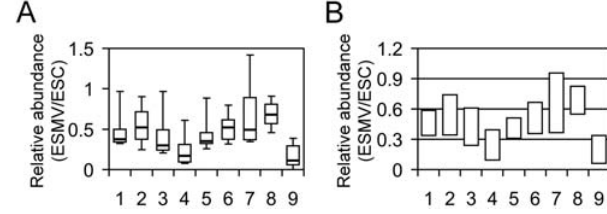
Figure 5. ESMVs contain miRNAs. The relative abundance of several miRNAs in ESMVs compared with ESCs was determined by real time quantitative RT-PCR. The miRNAs tested include miR-16 (lane 1), miR-21 (lane 2), miR-22 (lane 3), miR-290 (lane 4), miR-291-3p (lane 5), miR-292- 3p (lane 6), miR-294 (lane 7), miR-295 (lane 8), and the small nuclear RNA, RNU6b (lane 9). (A) Box plots of relative abundance in ESMVs compared with ESCs (n=9). The boxed area represents the mean 6- quartile and the whiskers extend out to the minimum and maximum values. Bootstrap ANOVA was performed and a significant difference was detected between all groups ( p =0.008). (B) The 95 th percentile confidence interval for each miRNA was determined and plotted on a bar graph. Non-overlapping groups are significantly different from each other. RNU6b is significantly less abundant than all miRNAs tested except for miR-22, miR-290, and miR-291. The majority of miRNAs tested do not differ significantly from one another except for miR-295 , which is significantly more abundant than miR-290 and miR-291